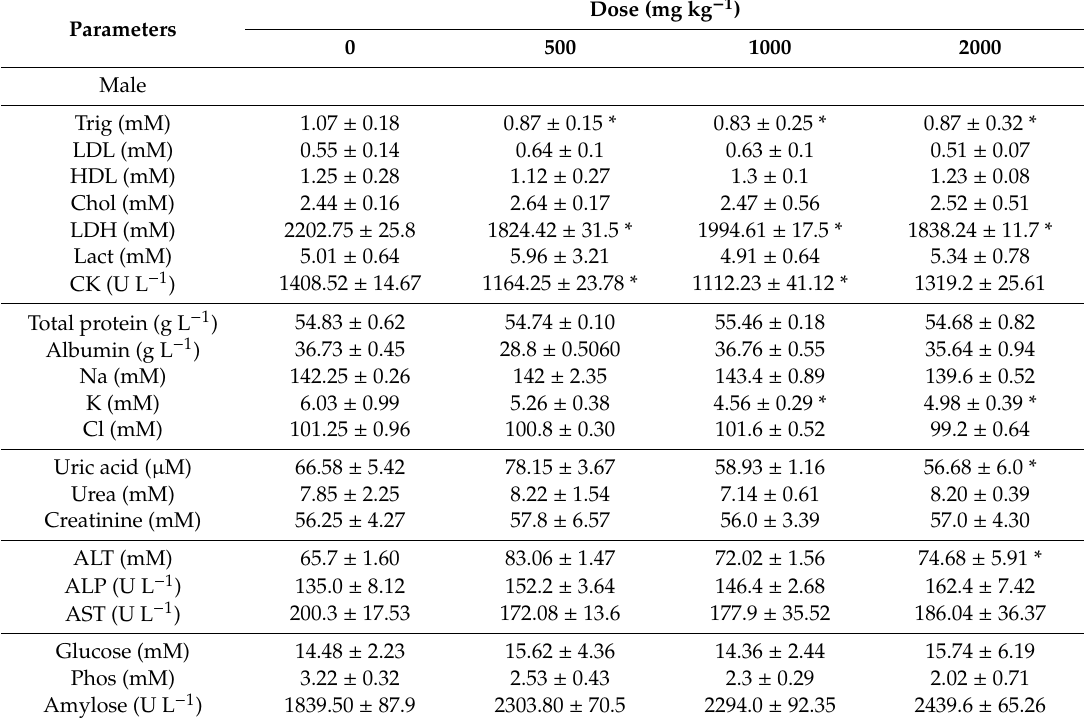
Table 7. Serum biochemical parameters of male and female rats treated with various palm puree doses for 28 d in a subchronic toxicity study. Data are means ± SD for groups of five animals / sex / dose. * ( p < 0.05) vs. control